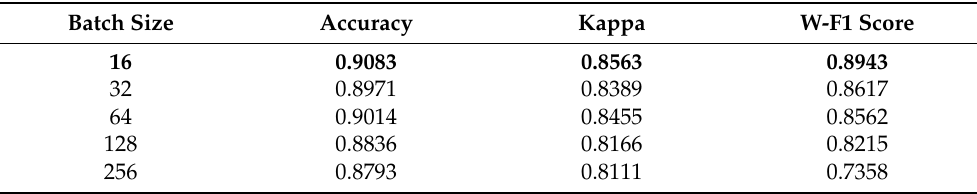
Table 5. Selection of batch size.